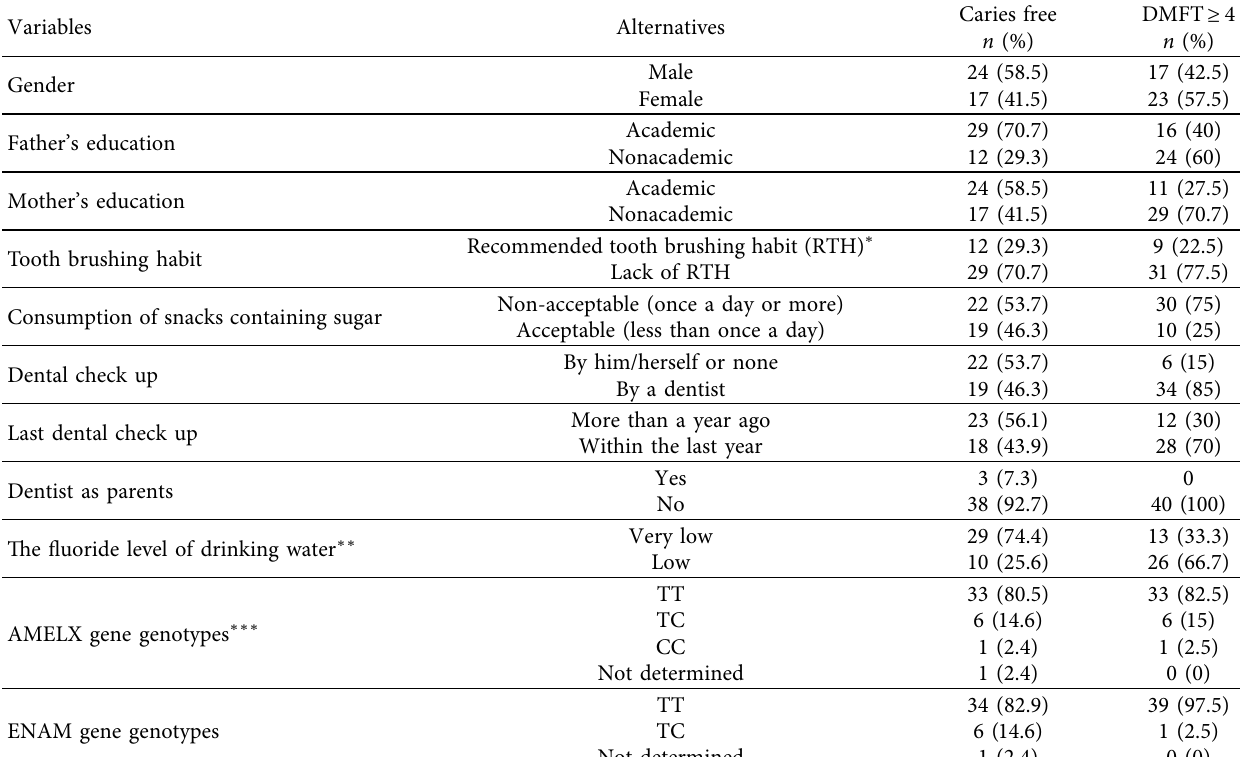
Table 2: Background information of two groups of Iranian 18–24 years medical sciences students selected, caries free ( n � 41) and those with DMFT ≥ 4 ( n � 40).